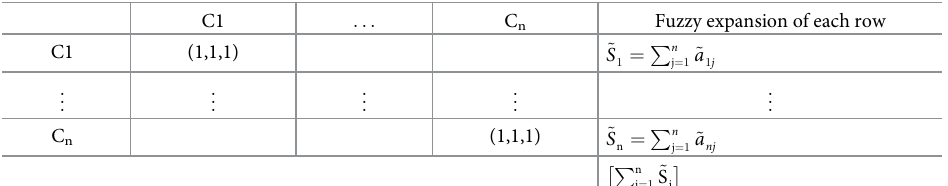
� � element. P n ~ a ¼ 1 1 j j ¼ 1